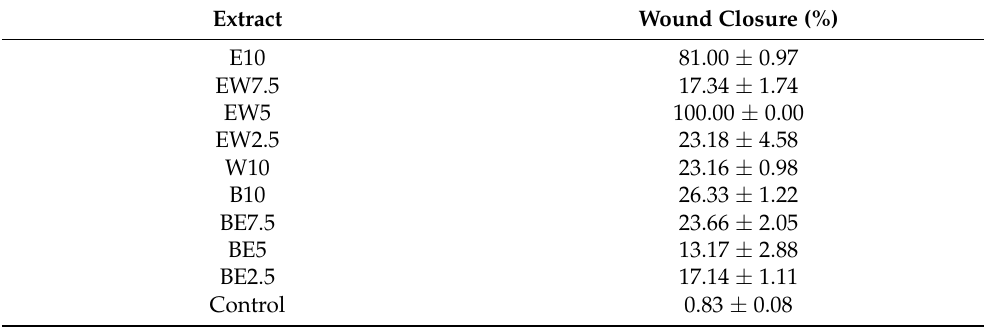
Table 8. Effects of the A. scorodoprasum flower extracts on wound healing in HaCaT cells. Results are presented as percentage of wound closure. NE—no effect on